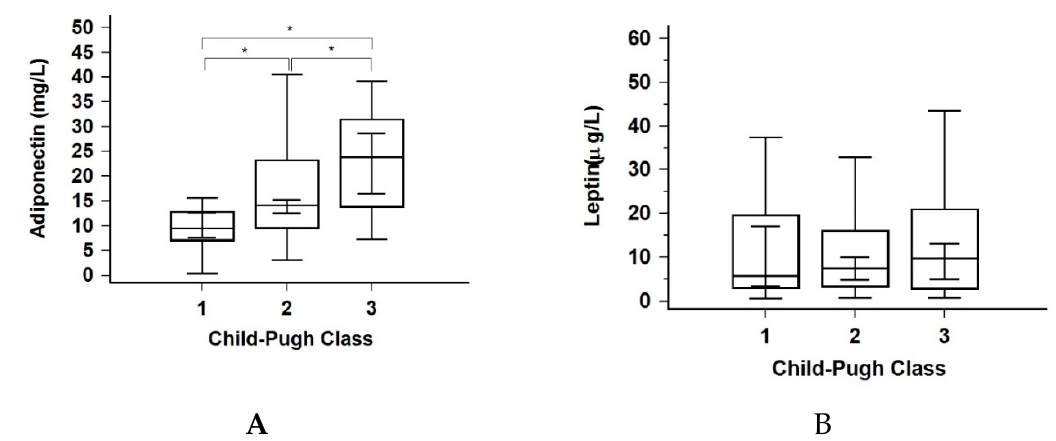
Figure 1. ( A , B ) Distributions of adiponectin and leptin through Child–Pugh classes. * p < 0.05.